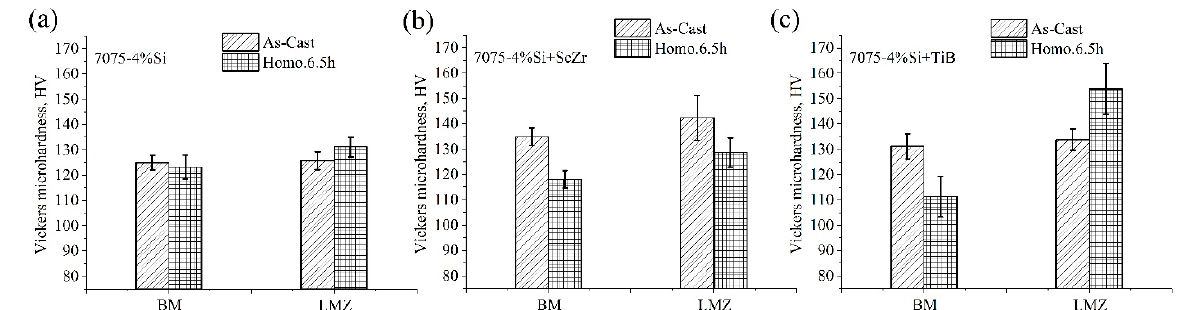
Figure 9. Vickers microhardness of the BM and the LMZ of the as-casted and homogenized alloys; ( a ) 7075-4%Si, ( b ) 7075-4%Si + ScZr, and ( c ) 7075-4%Si + TiB.